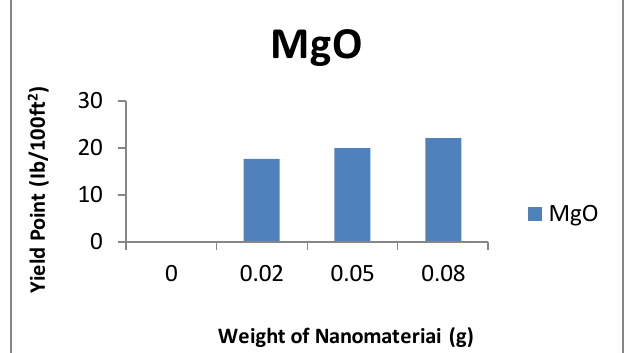
Figure 7: Effect of Nano-magnesium oxide Weight on Yield point of attapulgite water-based